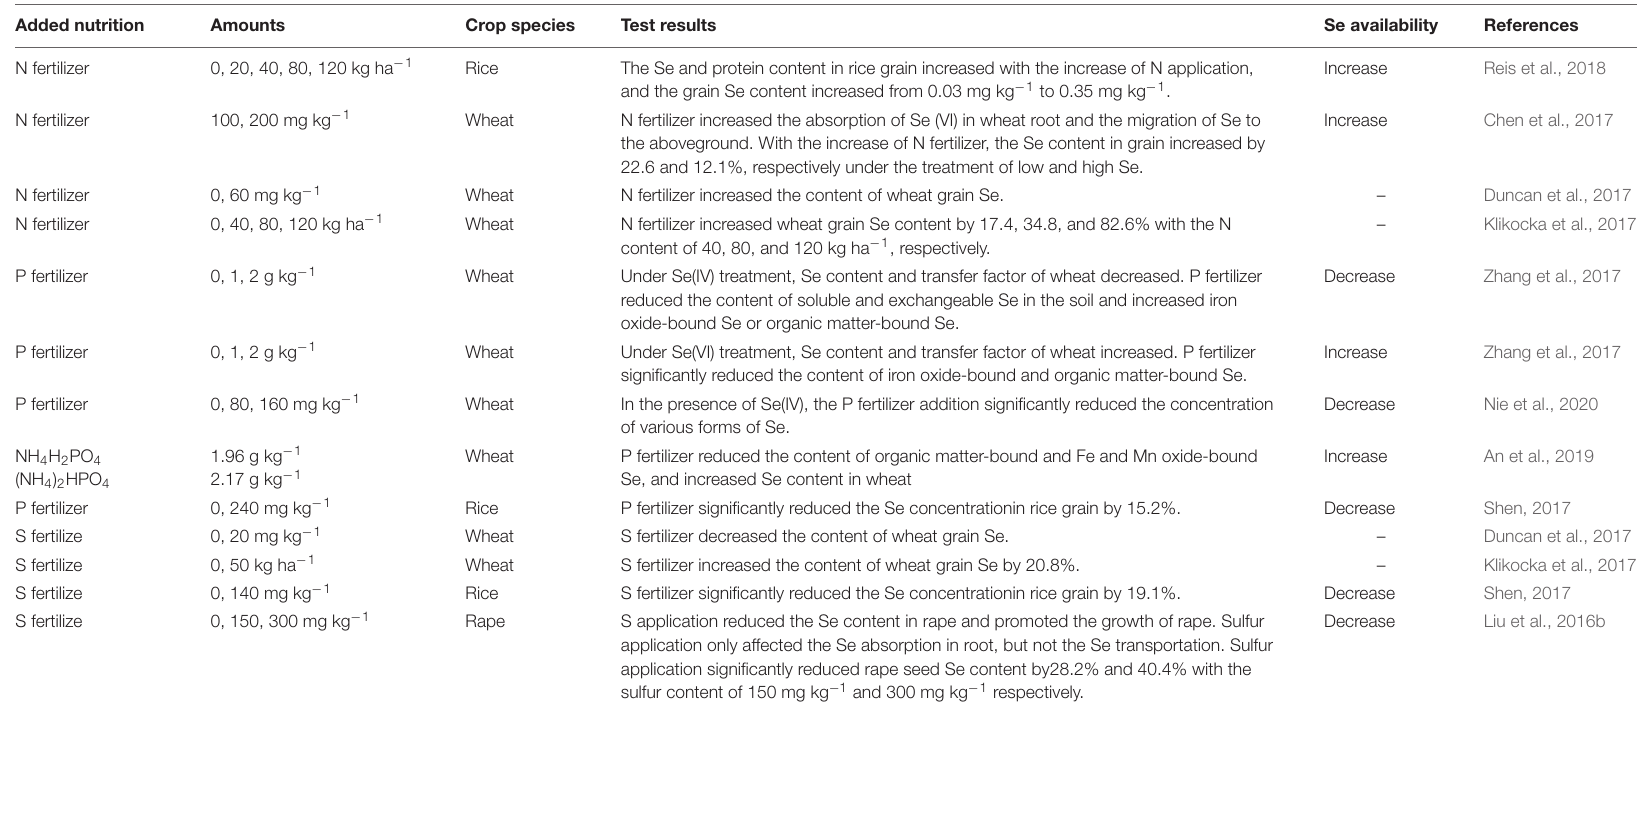
Wheat Under Se(IV) treatment, Se content and transfer factor of wheat decreased. P fertilizer reduced the content of soluble and exchangeable Se in the soil and increased iron oxide-bound Se or organic matter-bound Se. Under Se(VI) treatment, Se content and transfer factor of wheat increased. P fertilizer significantly reduced the content of iron oxide-bound and organic matter-bound Se. In the presence of Se(IV), the P fertilizer addition significantly reduced the concentration of various forms of Se. P fertilizer reduced the content of organic matter-bound and Fe and Mn oxide-bound Se, and increased Se content in wheat Rice P fertilizer significantly reduced the Se concentrationin rice grain by 15.2%. Wheat S fertilizer decreased the content of wheat grain Se. Wheat S fertilizer increased the content of wheat grain Se by 20.8%. S fertilizer significantly reduced the Se concentrationin rice grain by 19.1%. Rape S application reduced the Se content in rape and promoted the growth of rape. Sulfur application only affected the Se absorption in root, but not the Se transportation. Sulfur application significantly reduced rape seed Se content by28.2% and 40.4% with the sulfur content of 150 mg kg − 1 and 300 mg kg − 1